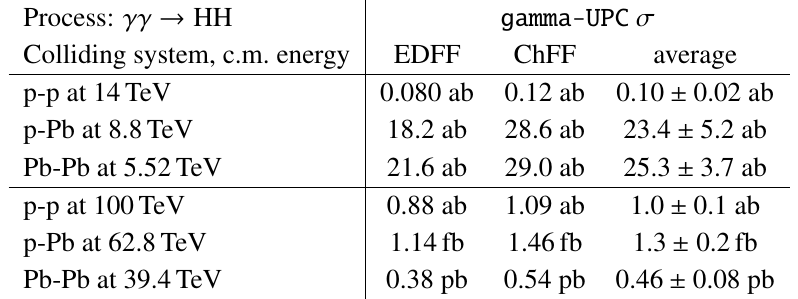
Table 11 . Total cross sections for (cid:13)(cid:13) ! HH in UPCs at the LHC, computed with EDFF and ChFF (cid:13) fluxes and their